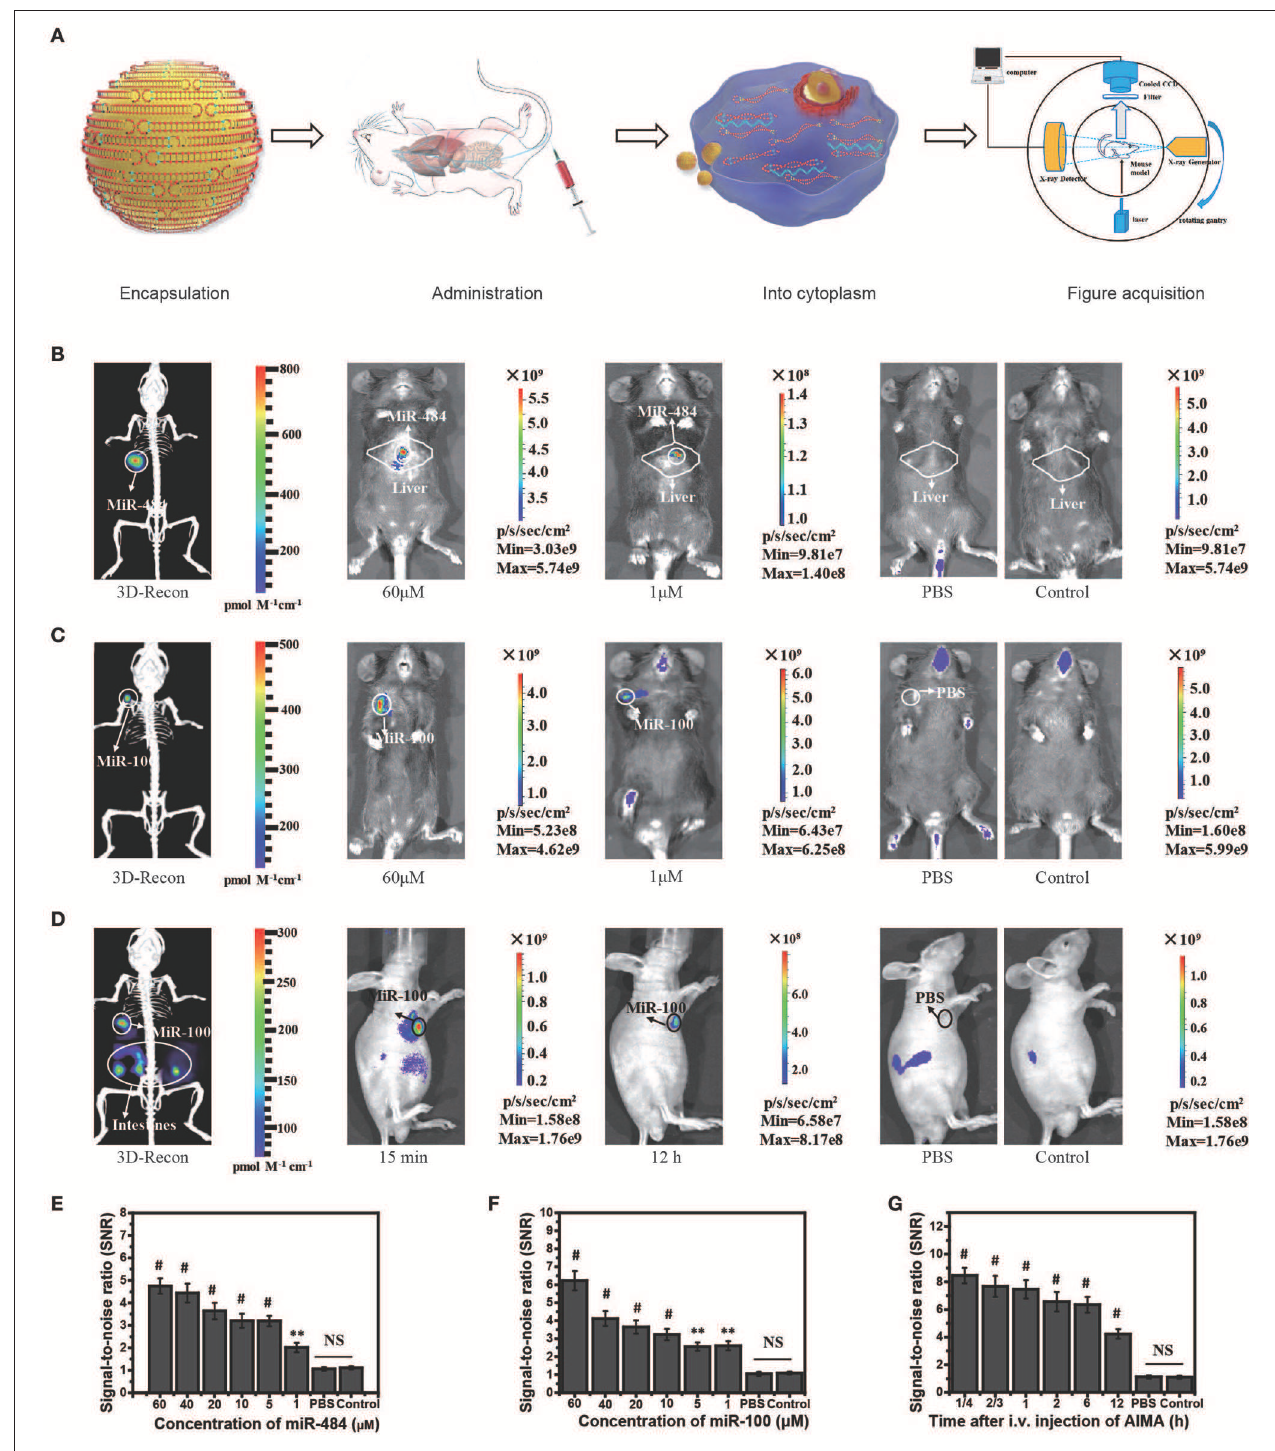
FIGURE 3 | Visualization and 3D reconstruction of microRNA (miRNA) in vivo based on miR-484-injected and miR-100 injection mouse models. (A) Flow chart of the experiments, including encapsulation of double-stranded SQ and FP in liposomes; administration of the artificial intelligent signal amplification (AISA) system; process of double-stranded SQ and FP entering the cytoplasm; and image acquisition based on a dual-modality system including a high-sensitivity fluorescence system and a microcomputed tomography system. (B) Fluorescence images and 3D reconstructed image of mice injected with miR-484 (25 µ l, 20 µ M) in the liver (depth, 2.5mm) at 10min after i.v. injection of the AISA 484 system. (C) Fluorescence images and 3D reconstructed image of mice injected with miR-100 in the femoral head at 10min